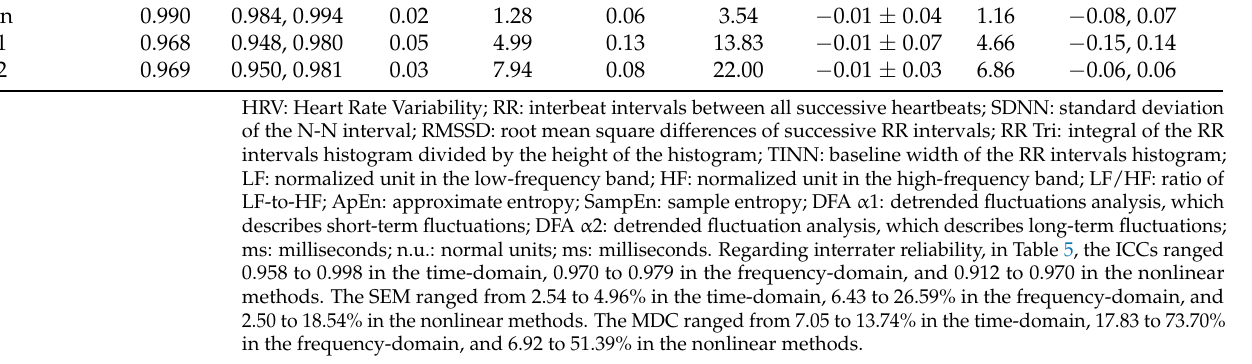
Table 5. Interrater reliability of HRV analysis of post-COVID-19 individuals in the supine